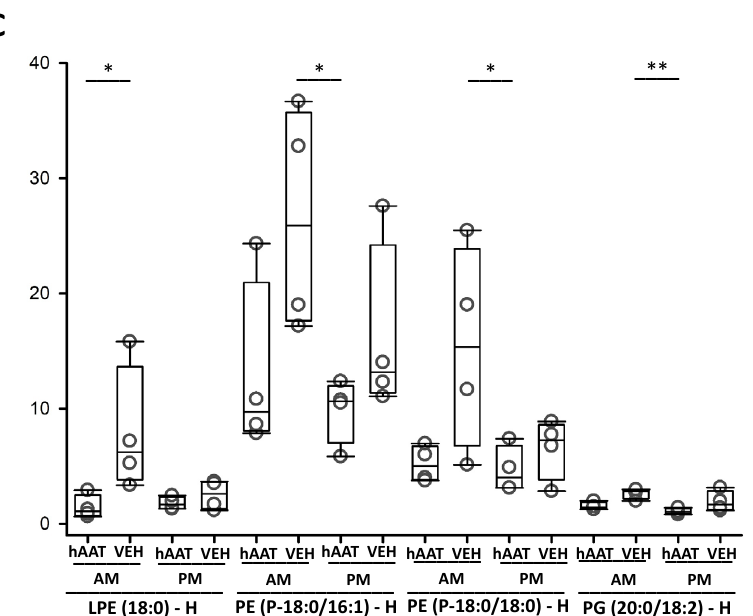
Figure 11. Lipidomics analysis of lipid classes enriched in urinary EVs from hAAT and vehicle treated db/db mice. Prior to lipid extraction, urinary EVs from each group was normalized to particles/mL. ( A ). Quantitative assessment of hexosylceramides (HCER). ( B ). Quantitative assess- ment of monoacylglycerol (MAG) and phosphatidylcholine (PC). ( C ). Quantitative assessment of lysophosphatidylethanolamine (LPE), phosphatidylethanolamine (PE), and phosphatidylglycerol (PG) from uEVs isolated from the urine during the active (AM) or inactive (PM) cycles of hypertensive diabetic mice treated with hAAT or vehicle. Samples were normalized to EV concentration. N = 4 hAAT AM, N = 4 vehicle AM, N = 4 hAAT PM, N = 4 VEH PM. AM reflects urine collected overnight during the active cycle of the mice and PM reflects urine collected during the day of the inactive cycle of the mice. * represents p -value < 0.05, ** represents p -value <